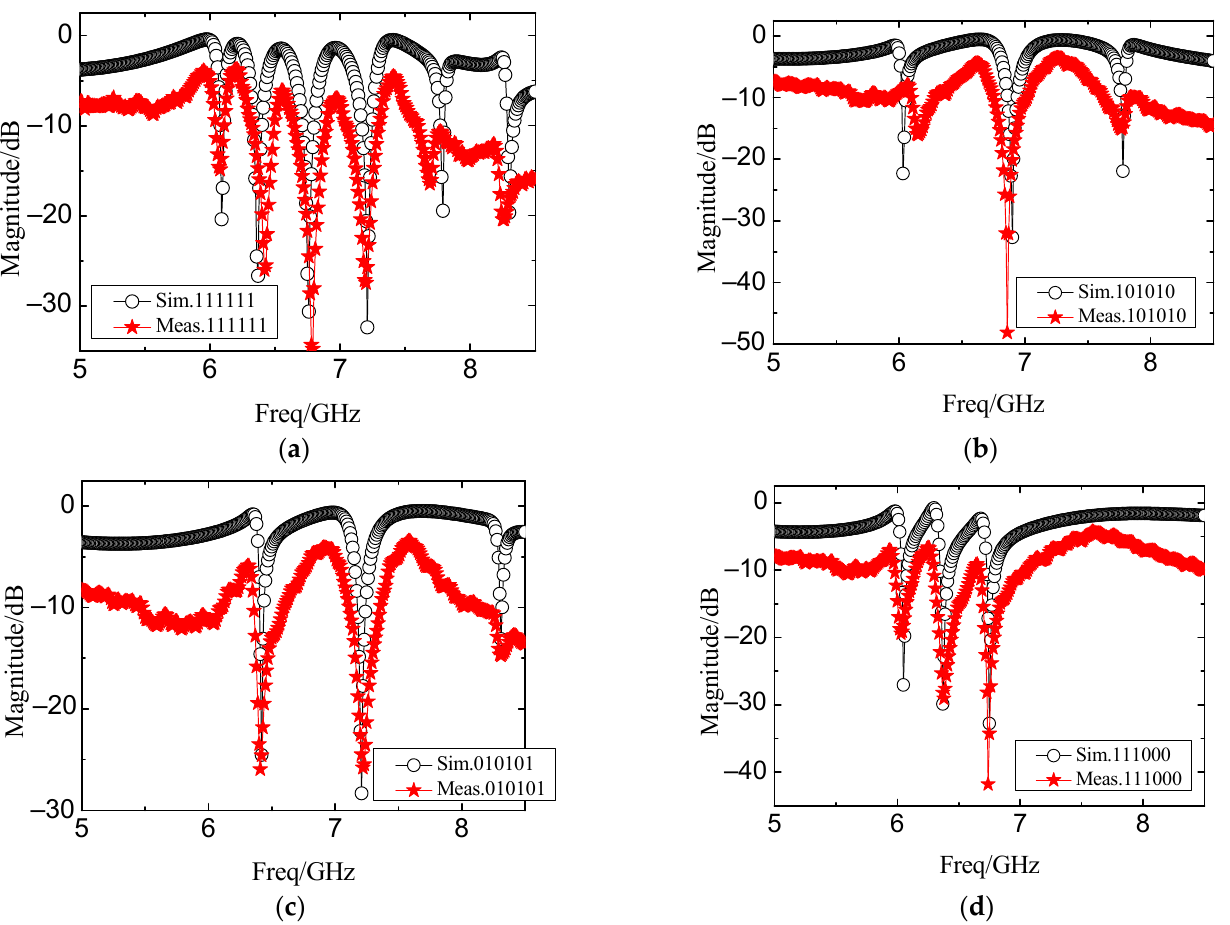
Figure 12. Simulation and measurement results of U-shaped slot resonator chipless tags: ( a ) ID111111; ( b ) ID101010; ( c ) ID010101; ( d ) ID111000.